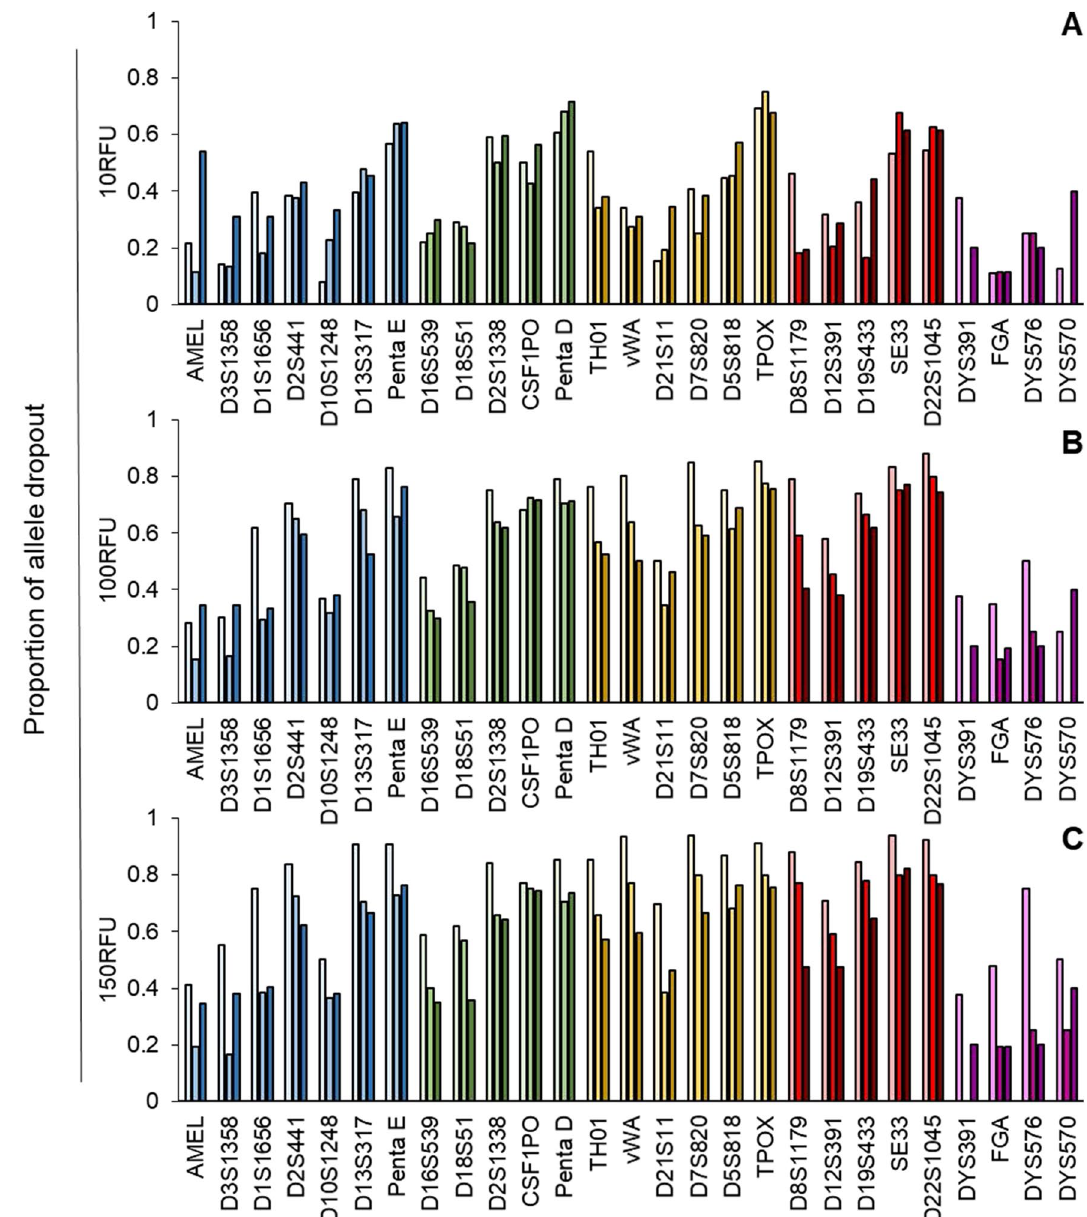
Figure 3. Average proportions of allele dropout by locus for single cells at 29, 30 and 31 cycles using the PowerPlex Fusion 6c kit analyzed at ( a ) 10 RFU, ( b ) 100RFU and ( c ) 150RFU. Cycle numbers within each locus from left to right are 29, 30, and 31, respectively and the colors (blue, green, yellow, red and purple) represent the dye